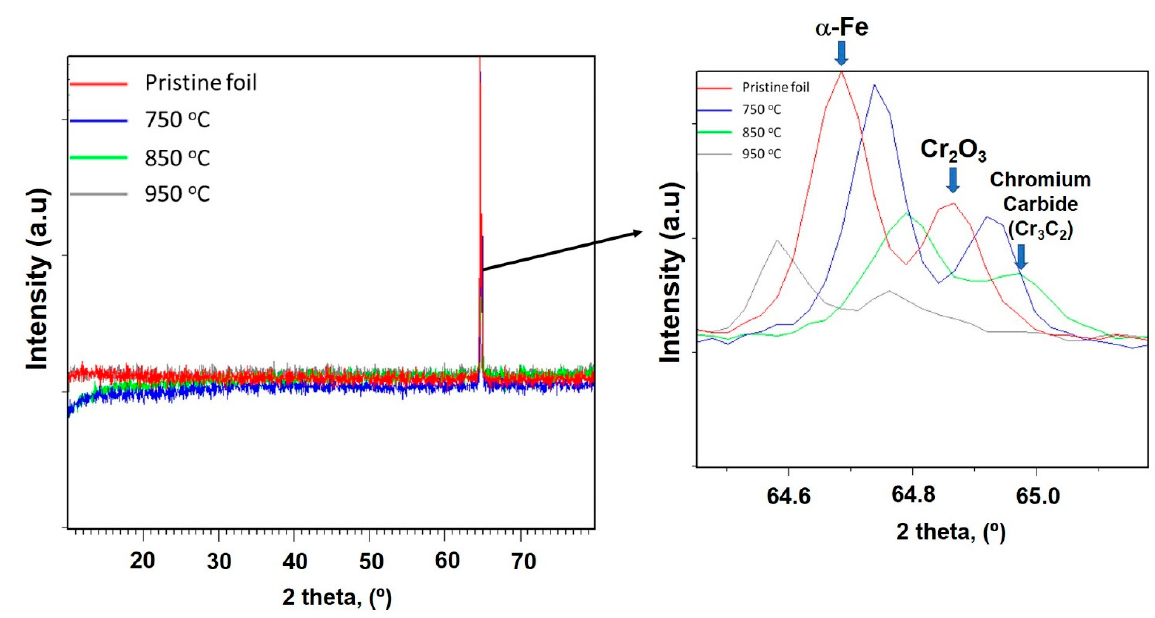
Figure 6. XRD patterns of the fresh and after pretreatment catalyst. However, a pretreatment at very high temperature may be leading to the melting issue due to the Ostwald ripening phenomenon and, as a result, small metal particles were destroyed. Figure 7 shows a certain number of melting positions in the SEM image of the catalyst after pretreatment at 950 °C. Figure 7. Melting points in the SEM image of the catalyst after pretreatment at 950 °C. Rectangles indicate melting point area.